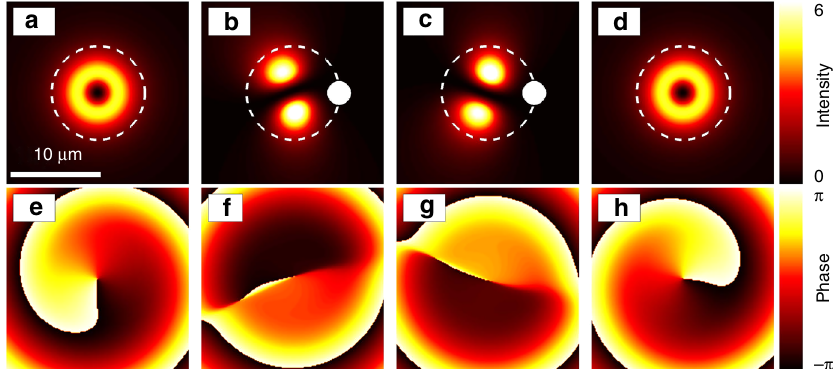
Fig. 2 Principle of optical vortex control. a – d Polariton density in μ m − 2 and e – h phase distribution in radians of vortices for different excitation settings. The vortex in a , e forms for excitation with only the ring-shaped CW pump with a pro fi le as indicated by the white dashed circle. When in addition to the ring-shaped CW pump a Gaussian control beam is switched on as indicated by the white spots, an oscillating dipole mode is created as shown in b , f and c , g at different points in time. d , h When the additional control beam is switched off again, the system returns to a vortex mode, however, with a rotation direction of the vortex that depends on the point in time at which the control is switched off. Here, panel d shows a successful vortex switching event with the vortex charge inverted after perturbation by the control beam as is apparent from the phase pro fi les in e and h . The gradient of the phase distribution de fi nes the local fl ow direction of the condensate.